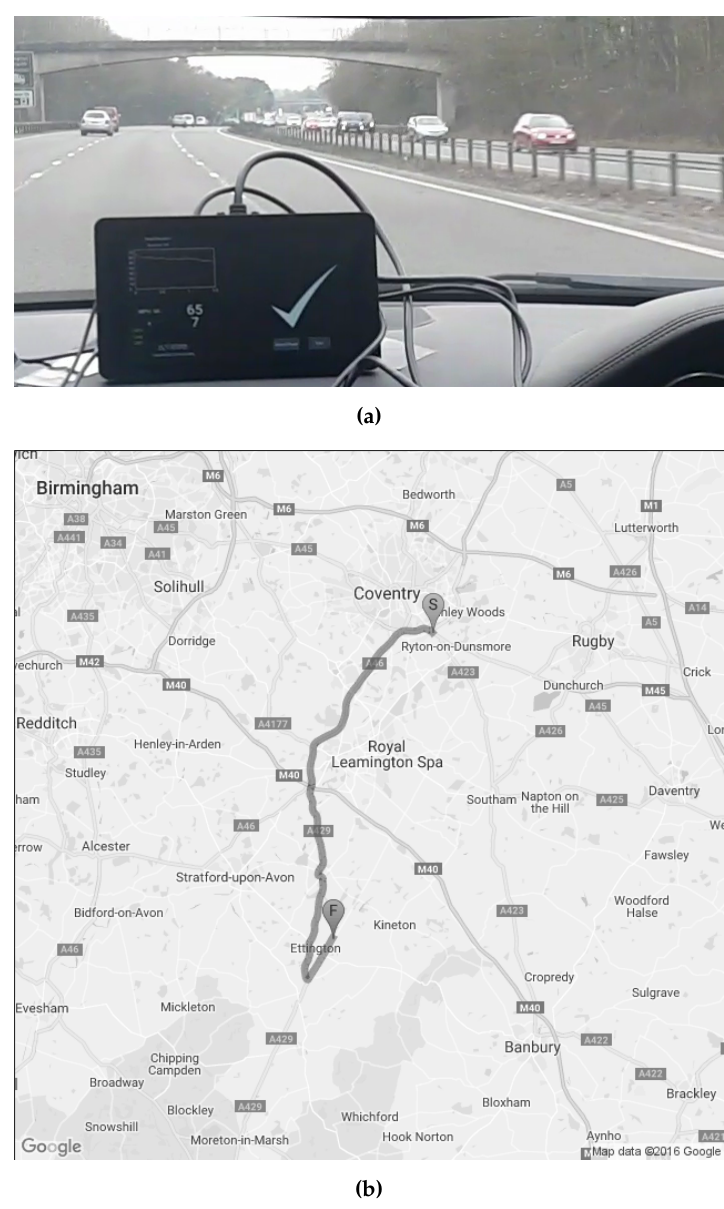
Figure 3. In-vehicle deployment of the eco-feedback system ( a ) Test route and ( b ) on the extra urban roads, including multi-lane free-way and single-lane country